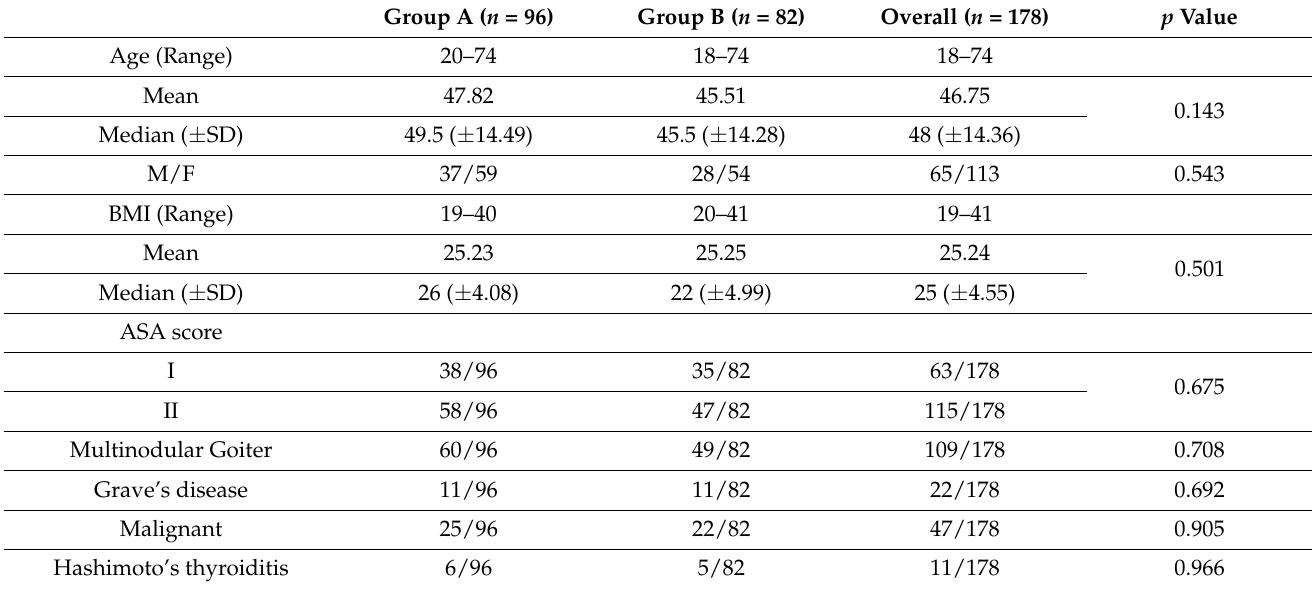
Table 1. Demographic data. BMI (Body Mass Index) and ASA score (American Society of Anesthesi- ologists). Significance tests include T tests for numerical variables and chi-square tests for categorical variables. A p value less than 0.05 was considered statistically